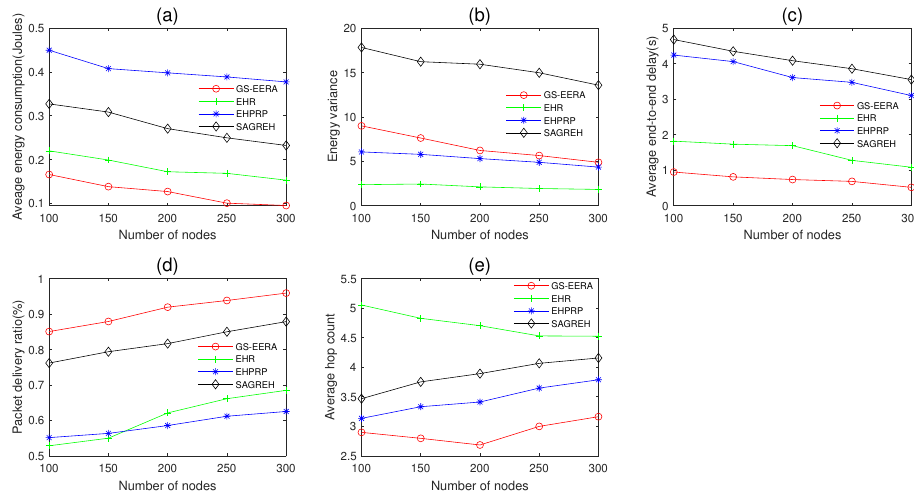
Figure 10. The impact of the number of nodes on ( a ) average energy consumption, ( b ) energy variance, ( c ) average end-to-end delay, ( d ) packet delivery ratio and ( e ) average hop